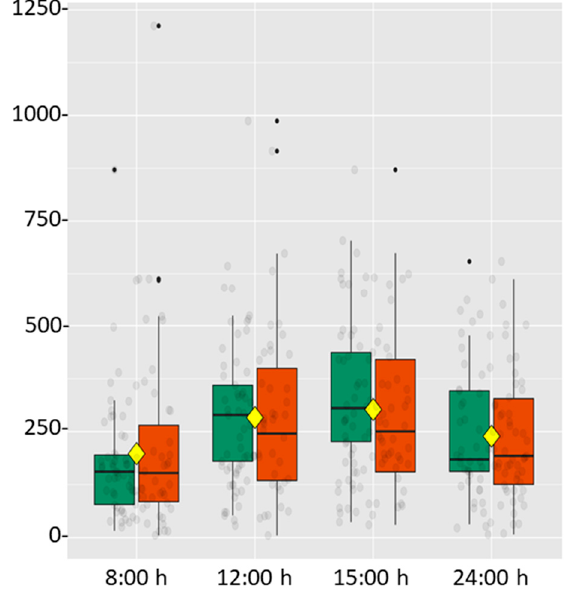
Figure 2. Box diagram of the pattern followed by salivary α -amylase throughout the working day according to gender. Green boxes correspond to men and red boxes to women. Enzyme levels are represented by arbitrary values. The yellow square corresponds to the mean value taking into account both genders. Black and grey dots represent the data distribution.